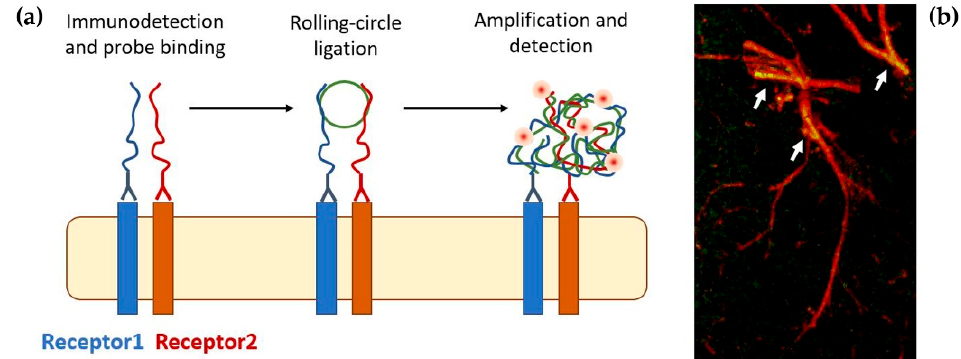
interacting receptors. The image shows the detection of adenosine A 2A -dopamine D 2 heteroreceptor complexes in astrocyte processes